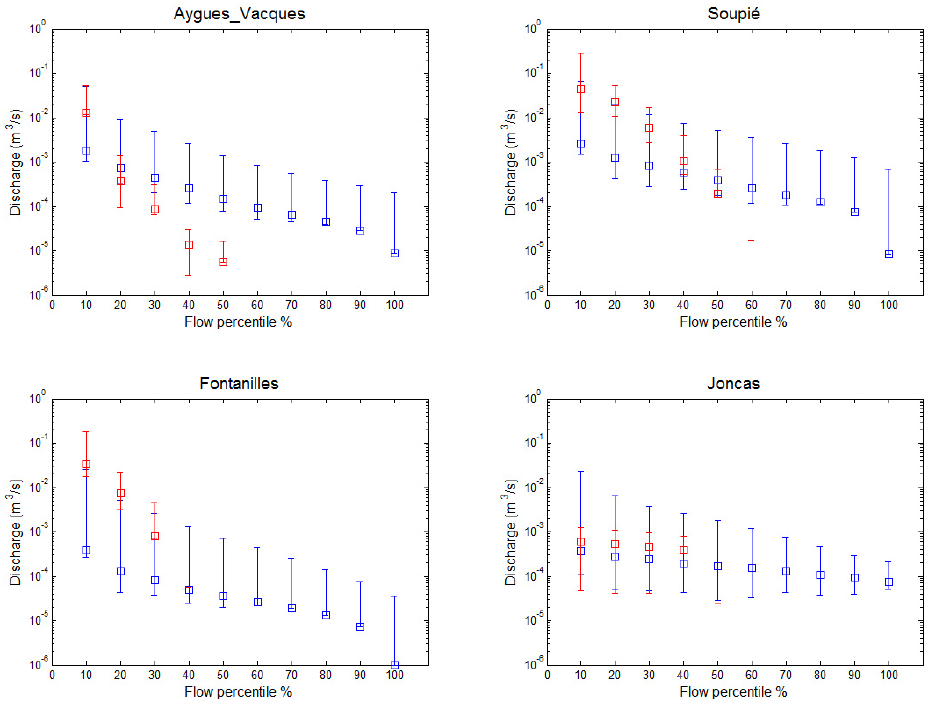
Figure 9. The 95% uncertainty interval of the simulated FDC flow percentiles versus 95% of the observed FDC flow percentiles re- sulting from the model parameters regionalization approach. Results correspond to the transfer of the Pallas model parameter sets to the Aygues_Vacques, Soupié and Fontanilles catchments and transfer of the Vène model parameter sets to the Joncas catchments. The blue color is for simulation and the red color is for observation. The bar corresponds to the 95% flow percentile value, while the square corresponds to the flow percentile median